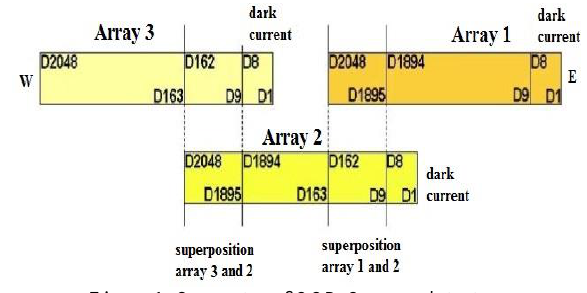
Figure 1. Geometry of CCD Camera detectors Among the causes of birth of noise in the image acquired by CCD Camera are mismatch in detectors, sensor calibration problems, inter detector variability and low signal-to-noise ratio